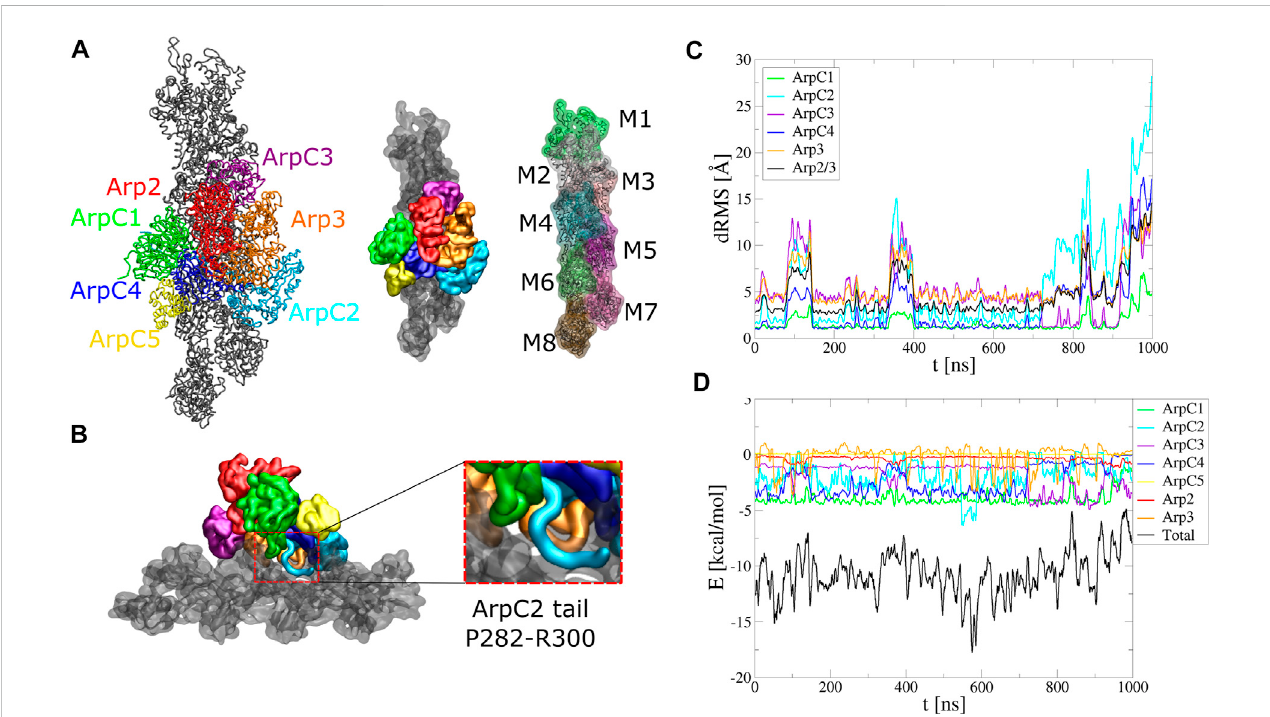
FIGURE 5 Arp2/3 complex binding to mother actin fi lament. Serial simulation starting from active Arp2/3 complex bound to the mother fi lament (PDB 7AQK). The Arp2/3 complex and mother actin fi laments are treated as separate rigid bodies except for fl exible regions in actin, Arp2, Arp3, and ArpC2 tail. (A) Initial con fi guration. (B) Side view showing typical con fi guration of ArpC2 tail during the simulation. Enlarged region shows the ArpC1 protrusion loop and ArpC2 C-terminal tail built between ArpC1 and ArpC4. (C) dRMS between mother actin fi lament and each of Arp2/3 complex subunits, as well as with entire Arp2/3 complex, with respect to PDB 7AQK. Arp2 and ArpC5 don ’ t start close enough to the actin fi lament to de fi ne a dRMS according to the criteria used in this paper. (D) Interaction energies between mother actin fi lament and Arp2/3 complex subunits or entire Arp2/3 complex as a function of time. The simulation was performed in a cubic box of side 300 Å for 1 μ